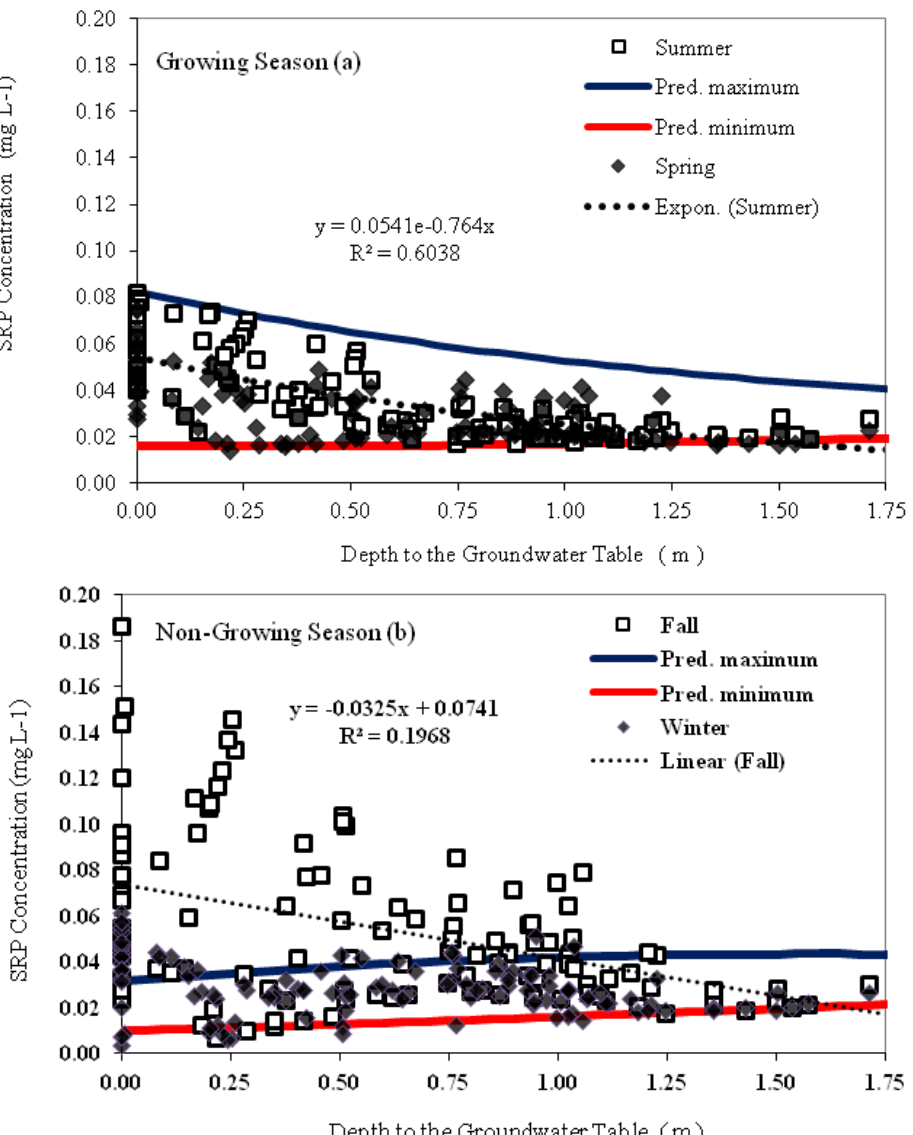
Figure 7. Observed SRP concentrations in groundwater plotted against groundwater